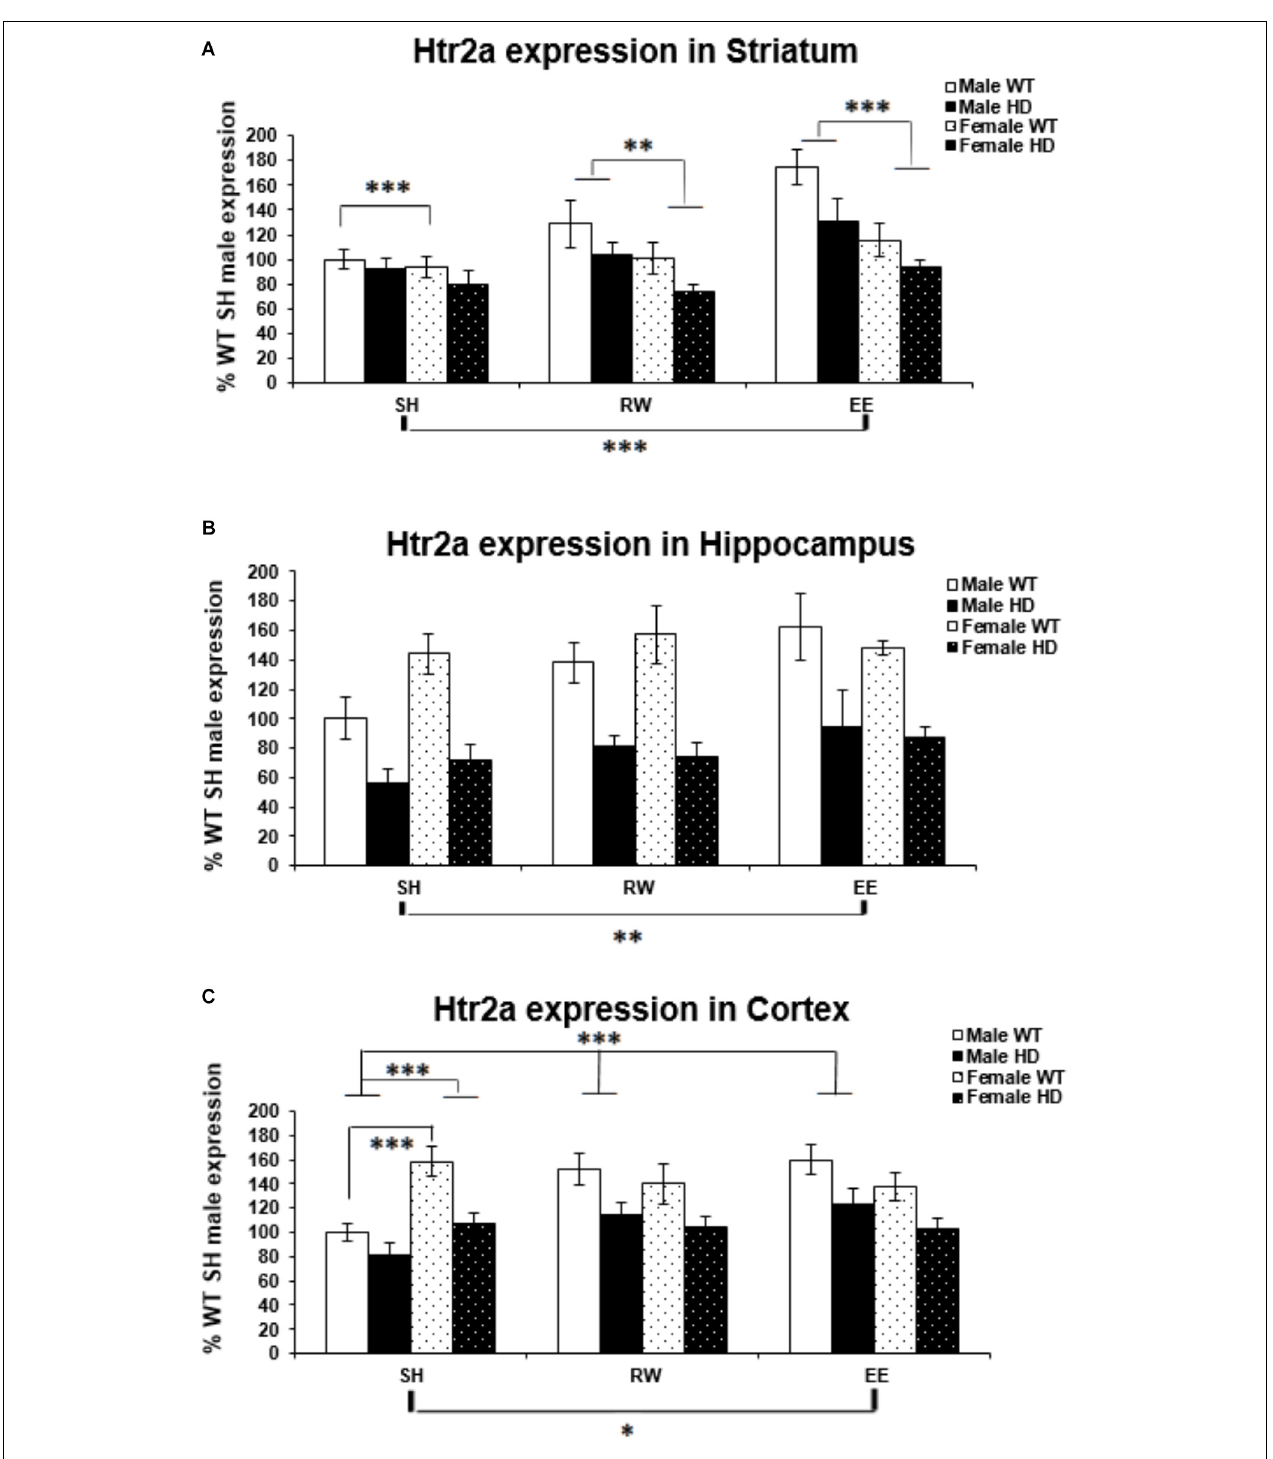
FIGURE 4 | Effects of genotype, environment and sex on Htr2a mRNA levels in 8-week-old WT and HD mice. (A) In Striatum, Htr2a expression was reduced significantly in 8-week-old HD mice ( p = 0.001). Housing environment had a significant effect on Htr2a expression ( p < 0.001). Post hoc testing showed that environmental enrichment ( p < 0.001), but not wheel running ( p = 0.461), significantly increased levels of Htr2a mRNA compared to SH. There was also a significant effect of sex on Htr2a expression ( p < 0.001) and a trend toward an interaction between sex × housing environment ( p = 0.063); pairwise comparison showed that male mice had significantly higher levels of Htr2a mRNA than their female counterparts when held under EE and RW conditions ( p < 0.001 and p = 0.018, respectively) and that EE significantly increased Htr2a expression levels in male mice compared to SH and RW conditions ( p < 0.001 and p = 0.008, respectively).